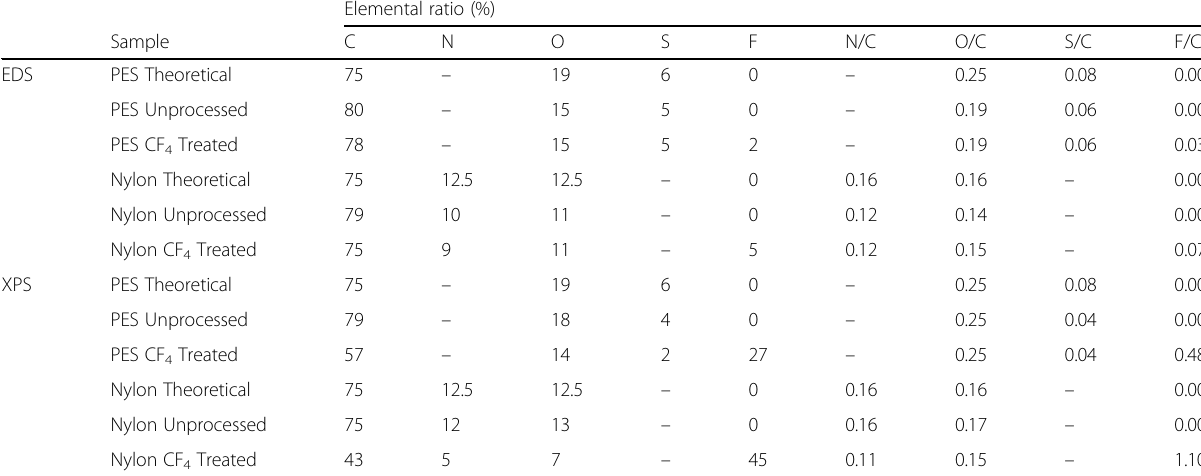
Table 3 Surface chemical composition and atomic ratio of change of Nylon and PES modified by CF 4 plasma treatment ( n =